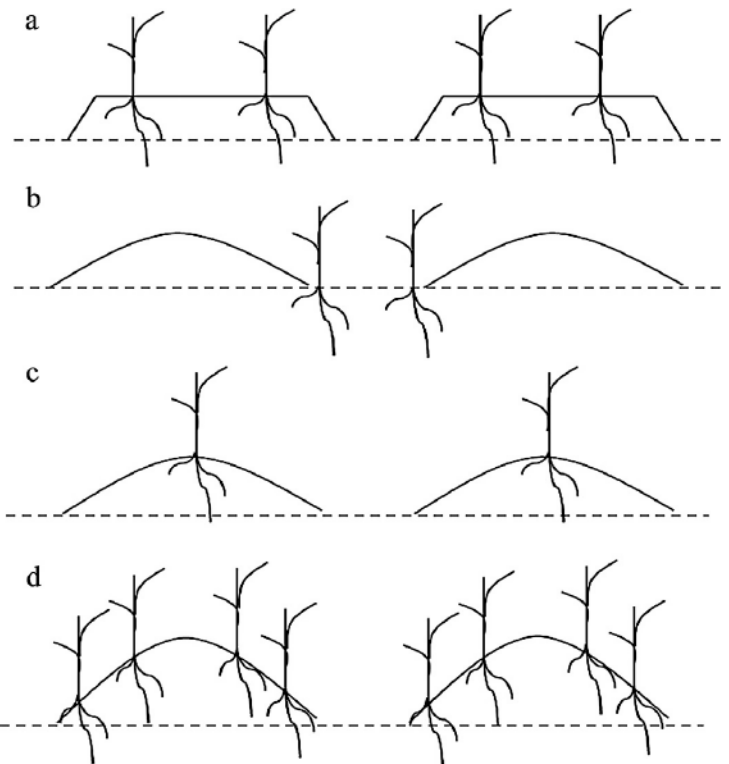
Figure 1. Four basic forms in the ridge tillage technology. ( a – d ) were bed (wide ridge) cultivation model, ridge and furrow planting of rainfall harvesting model, ridge mulching and planting of warming and water conservation model.